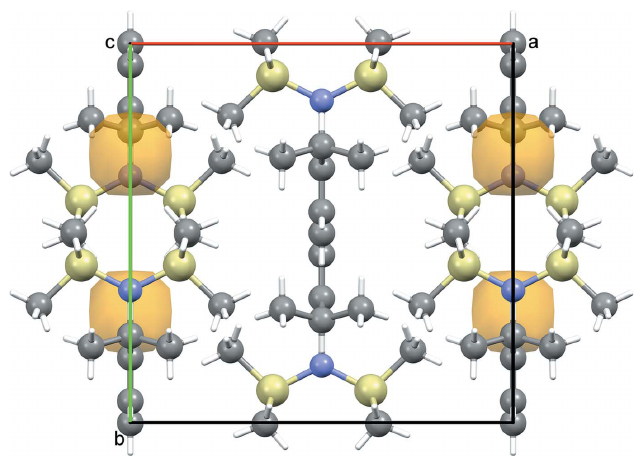
Figure 4 Unit-cell packing diagram for (III) viewed perpendicular to c with H atoms shown with arbitrary radii. Small, non solvent-accessible, voids of 22 A˚ 3 are shaded ochre.